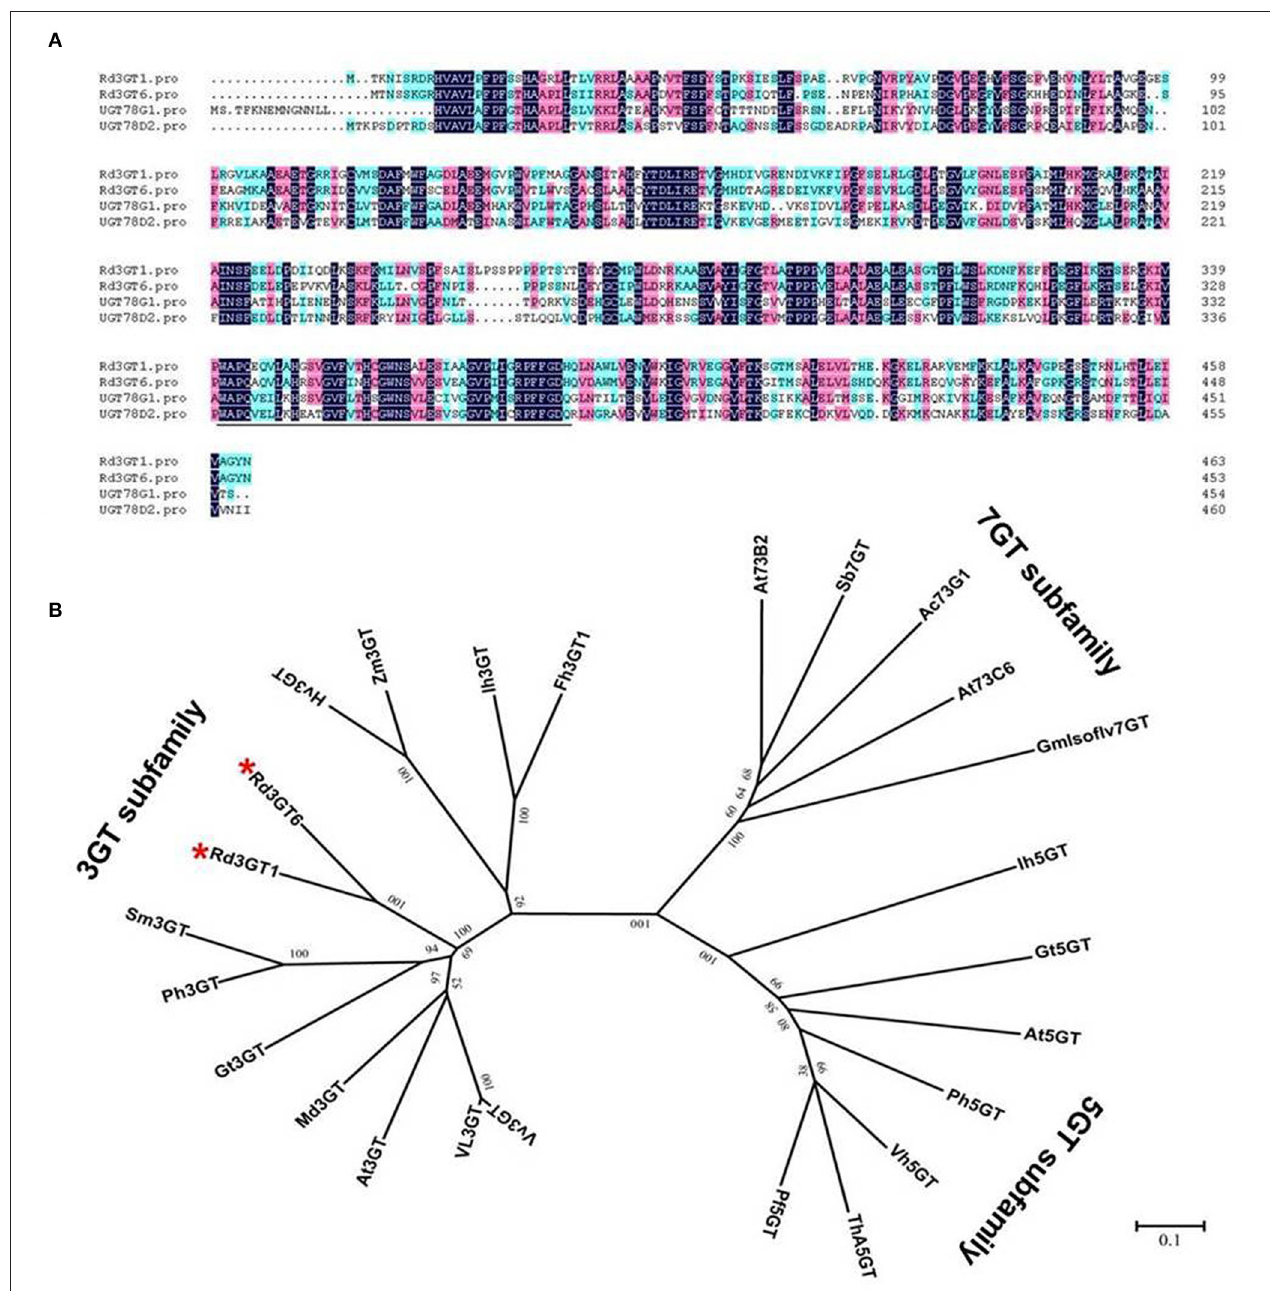
FIGURE 3 | Sequence alignment and phylogenetic analyses of Rd3GT1 and Rd3GT6 . (A) Sequence alignment of Rd3GT1 and Rd3GT6 with UGT78D2 ( Arabidopsis thaliana , NM_121711.5) and UGT78G1 ( Medicago sativa , A6XNC6). The PSPG motif that interacts with the sugar donor is underlined. (B) Phylogenetic analyses of the deduced amino acids of Rd3GT1 and Rd3GT6 and UFGTs from different plant species. GenBank accession numbers are as follows: VvFd3GT ( Vitis vinifera AAB81683), Vl3GT ( Vitis labrusca ABR24135), Mt3GT ( Medicago truncatula XP_003610163), At3GT ( Arabidopsis thaliana , NM_121711.5), Gt3GT ( Gentiana triflora Q96493.1), Ph3GT ( Petunia hybrida AB027454), Sm3GT ( Solanum melongena Q43641), Zm3GT ( Zea mays CAA31856), Hv3GT ( Hordeum vulgare CAA33729), Ih3GT ( Iris hollandica BAD83701), Fh3GT1 ( Fressia hybrida ADK75021.1), Ih5GT ( Iris hollandica BAD06874), Gt5GT ( Gentiana triflora BAG32255), At5GT ( Arabidopsis thaliana NP_193146), Pf5GT ( Perilla frutescens BAA36421), Th5GT ( Torenia hybrid BAC54093), Ph5GT ( Petunia hybrida AB027455), Vh5GT ( Verbena hybrida AB076698), Sb7GT ( Scutellaria baicalensis BAA83484), At73B2 ( Arabidopsis thaliana NM_179161.2), At73C6 ( Arabidopsis thaliana NM_129234.2), Ac73G1 ( Allium cepa AAP88406), GmIsoflv7GT (Glycine max ABB85236.1). Rd3GT1 and Rd3GT6 are highlighted in red